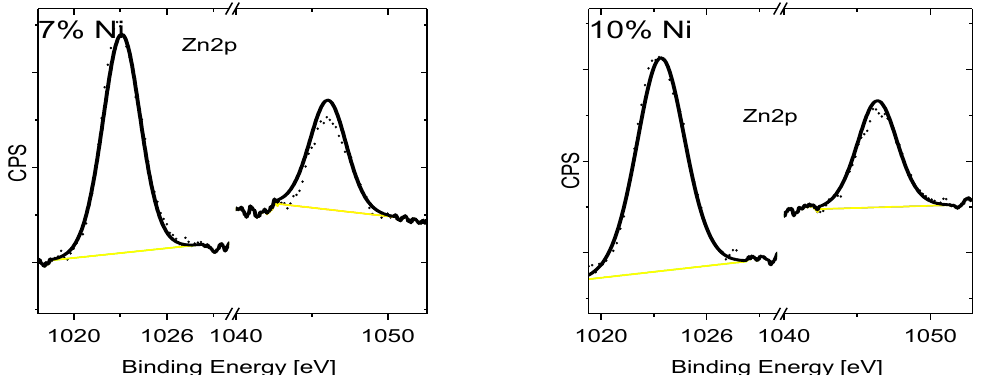
Figure 10. XPS recorded for the ZnNiO samples containing 1%, 3%, 7% and 10% Ni weight percentages. High-resolution XPS spectra are plotted for the Zn 2p photoelectrons.